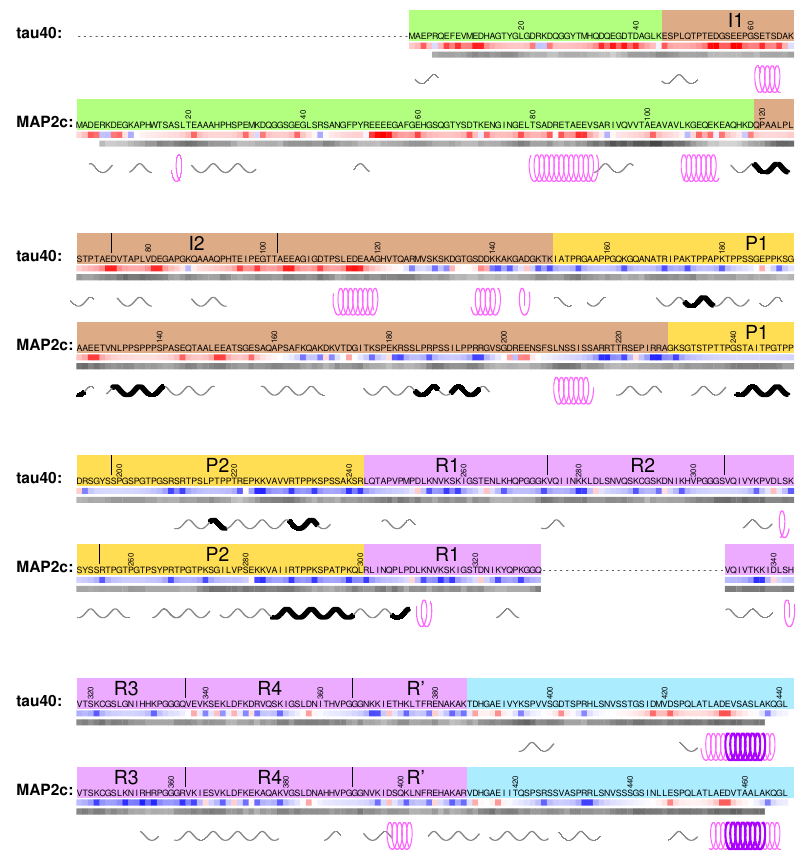
Figure 2. Sequences of human tau40 and rat MAP2c shown with backgrounds distinguishing individual regions. The pale green background indicates the N-terminal region, the brown background